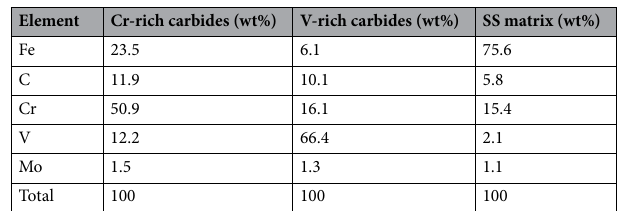
Table 1. EDX analysis of the Cr-rich and V-rich carbides of the EBM-processed high carbon martensitic stainless steel.